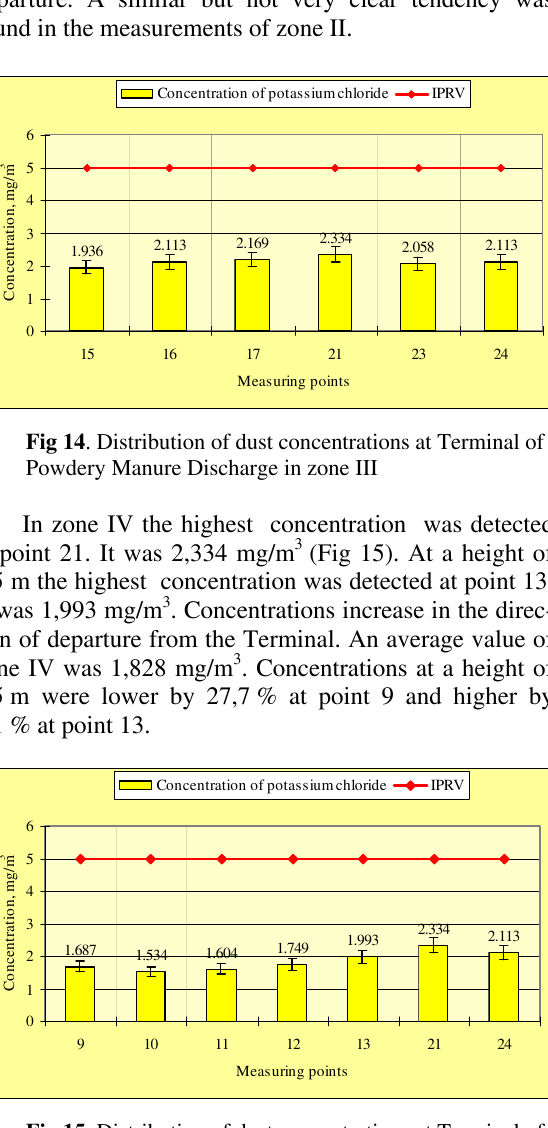
Fig 15 . Distribution of dust concentrations at Terminal of Powdery Manure Disharge in zone